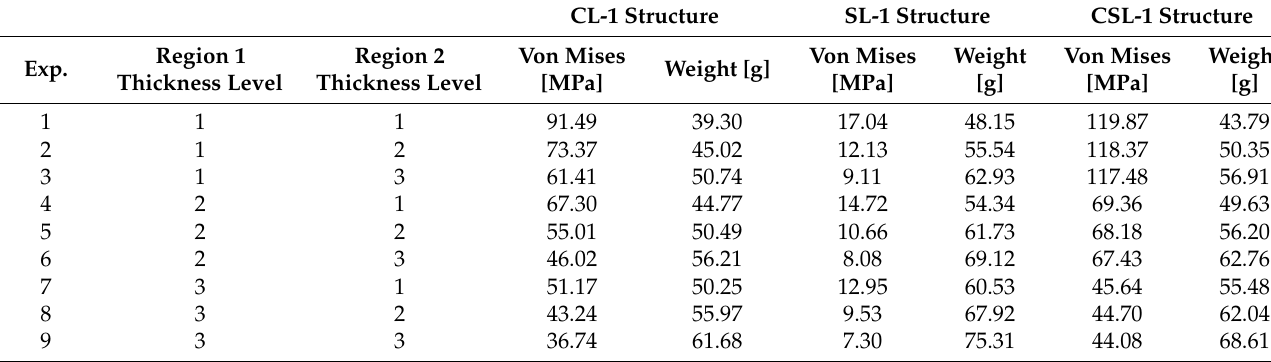
Table 5. L9 DOE of von Mises and weight for the CL-1, SL-1, and CSL-1